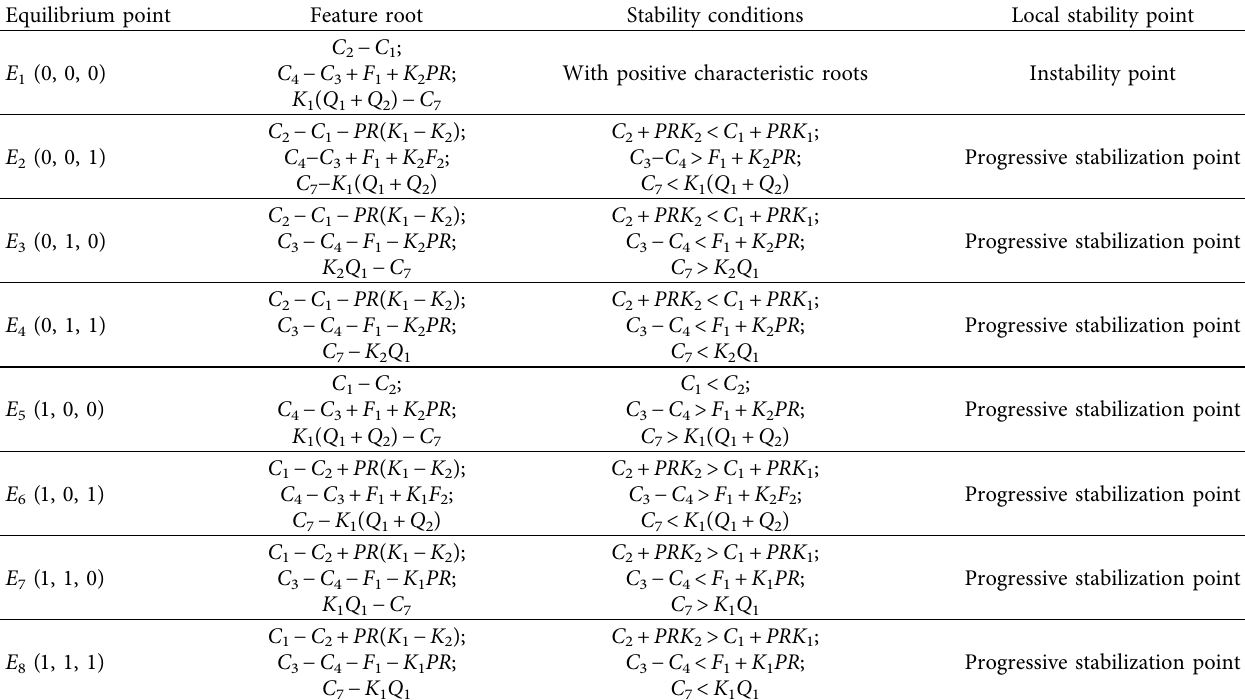
Figure 6: Te evolutionary process of Table 3: Equilibrium point analysis.